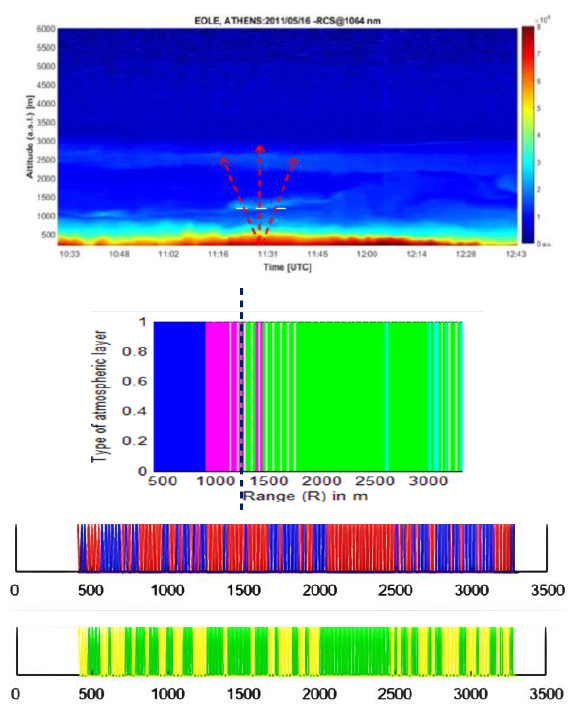
Fig. 2. (Upper) RCS signal acquired at 1064nm by the LRSU-NTUA lidar with METCON PBLH presentation in 3D, using the UNIFORM technique. The white dashed line denotes PBLH outcome with METCON-PBLH at 1372.5m while radiosonde data obtained by the HNMS around